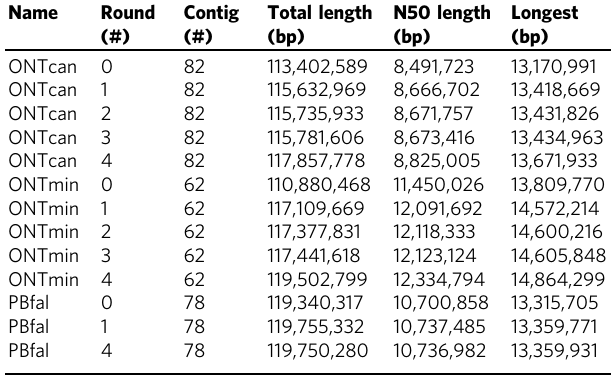
Table 1 Metrics of the KBS-Mac-74 Oxford Nanopore MinION and Paci fi c Biosciences Sequel assemblies